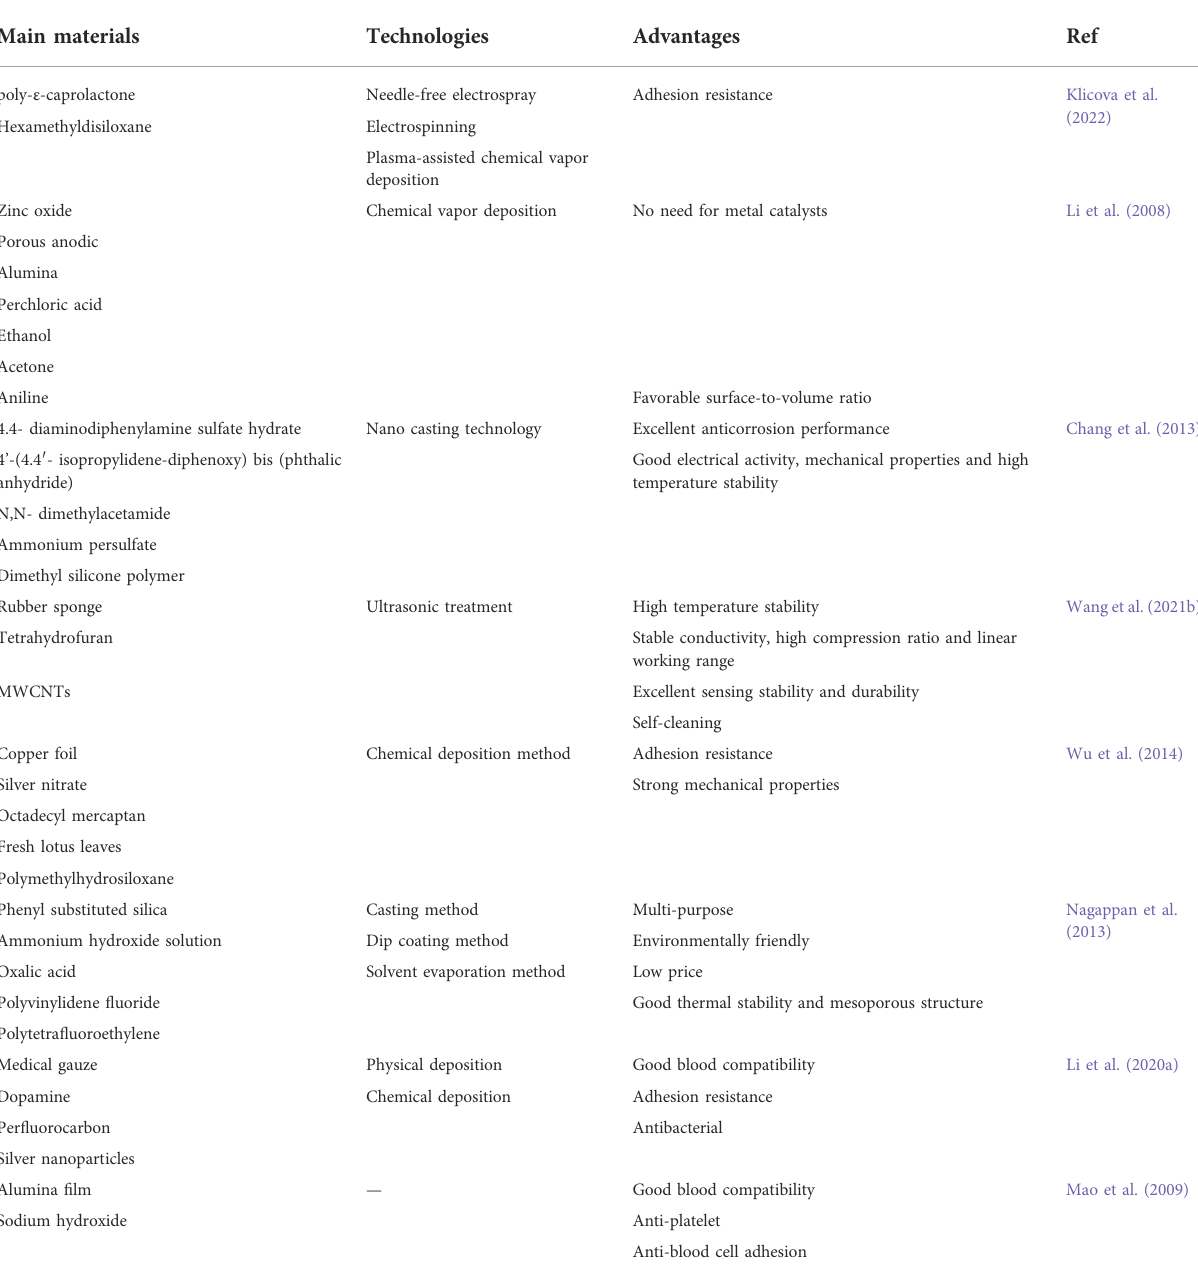
TABLE 2 Bionic product with lotus leaf as